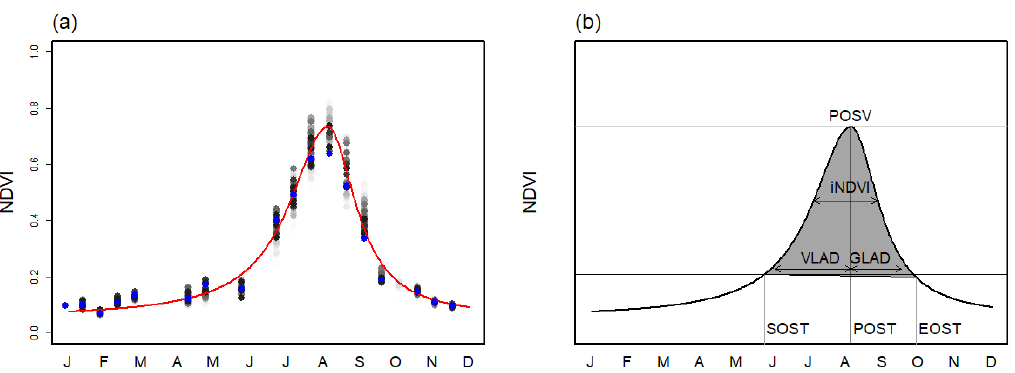
Figure 2. Demonstration of: ( a ) Spatially weighted growth curve estimation, where the estimated growth curve is shown in red, NDVI data used in the estimation are shown in shades of grey according to their spatial weight (white lowest and black highest) and NDVI data for the cell are shown in blue and ( b ) calculation of phenological metrics.